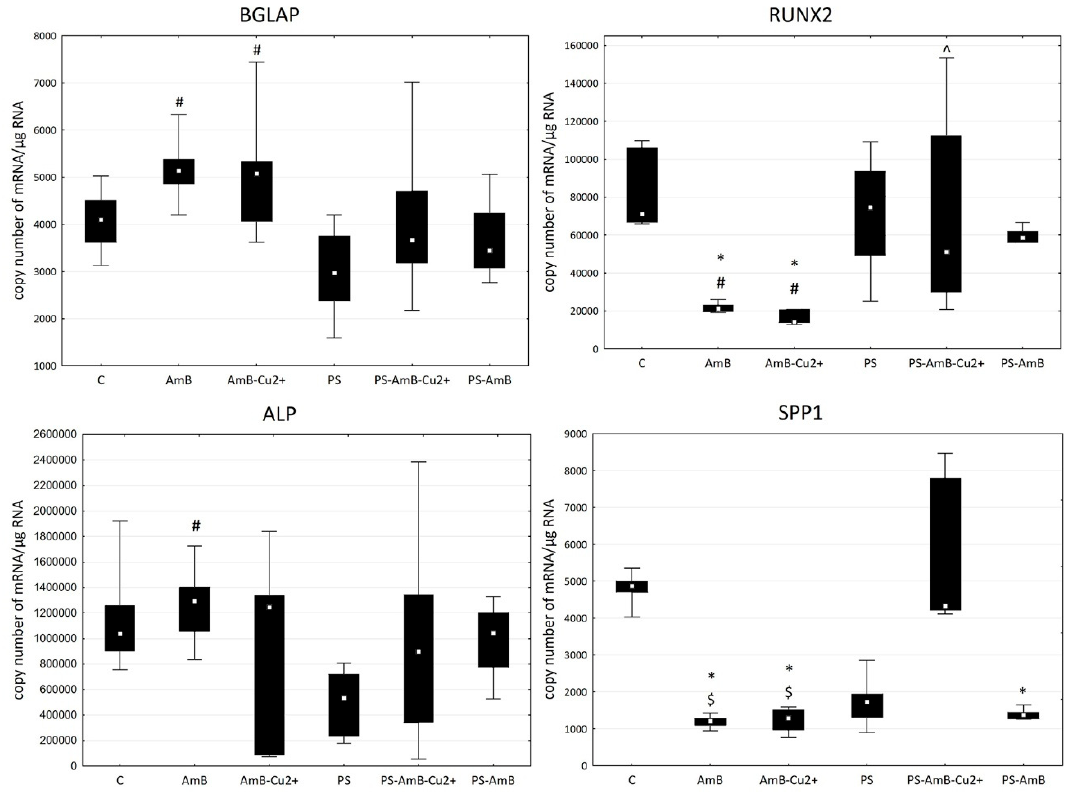
Figure 10. The mRNA levels of osteogenic markers BGLAP , RUNX2 , SPP1 and ALP in the ADSC after exposure of ADSC to the tested combinations of antibiotics. The bars represent the (Me) with the 25th and 75th quartiles and the minimum and maximum of the copy numbers per 1 µg of total RNA; the Kruskal–Wallis test with post hoc was applied to assess any differences in the expression of the genes, * p < 0.05 vs. control, ^ p < 0.05 vs. AmB-Cu 2+ , # p < 0.05 vs. PS, $ p < 0.05 vs. PS-AmB-Cu 2+ .